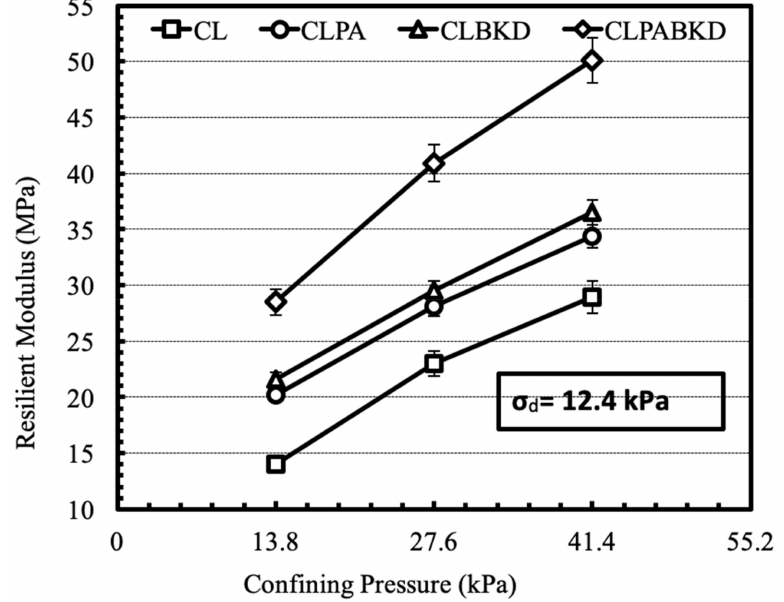
Figure 16. Variation in M R of optimum mixtures (soaked) with confining pressure at a cyclic deviator stress of 12.4 kPa.